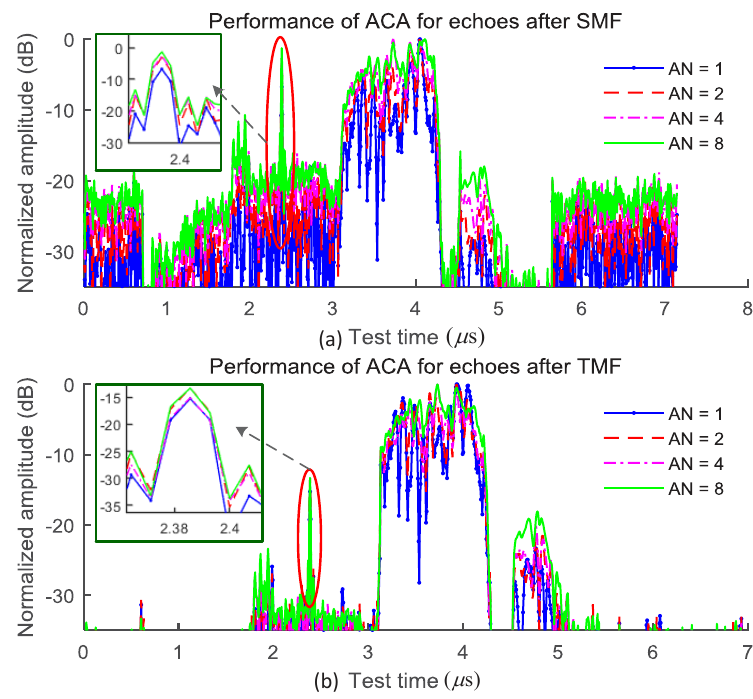
Figure 5. Performance comparison of the ACA method under different accumulation numbers. ( a ) The performance of the ACA based on the echoes filtered by SMF; ( b ) The performance of the ACA based on the echoes filtered by